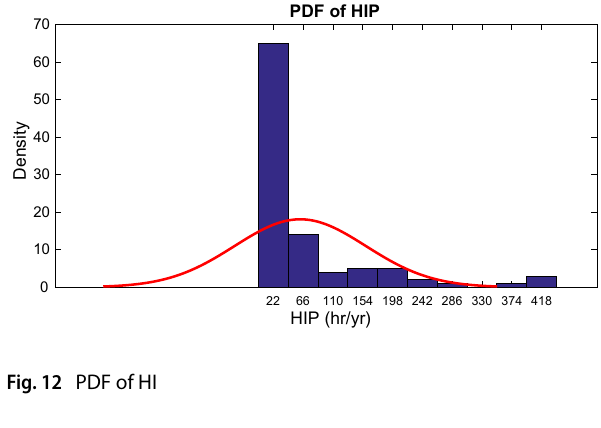
Fig. 12 PDF of HI